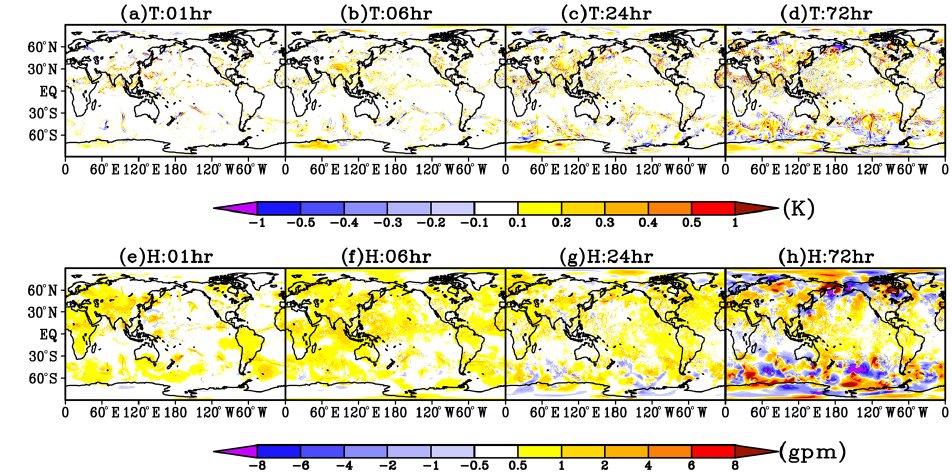
Figure 8. Distribution of the differences (G00 minus G21) of temperature field (a–d) and geopotential height field (e–h) at 500hPa simulated by G00 and G21 experiments. The units of temperature and geopotential height are K and gpm, respectively.